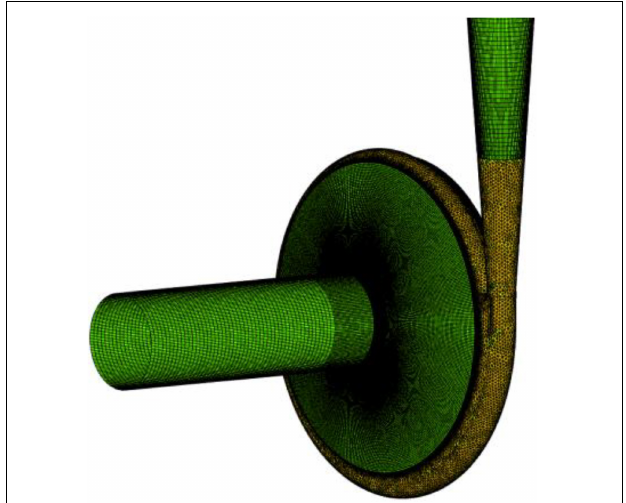
FIGURE 2 | Diagram of flow field domain.